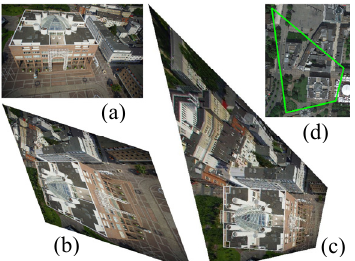
Figure 4. (a) Initial image, (b) Rectified image using the affine transformation, (c) Rectified image using the homography transformation, (d) Thumbnail of the image footprint shown in Google Earth (manually